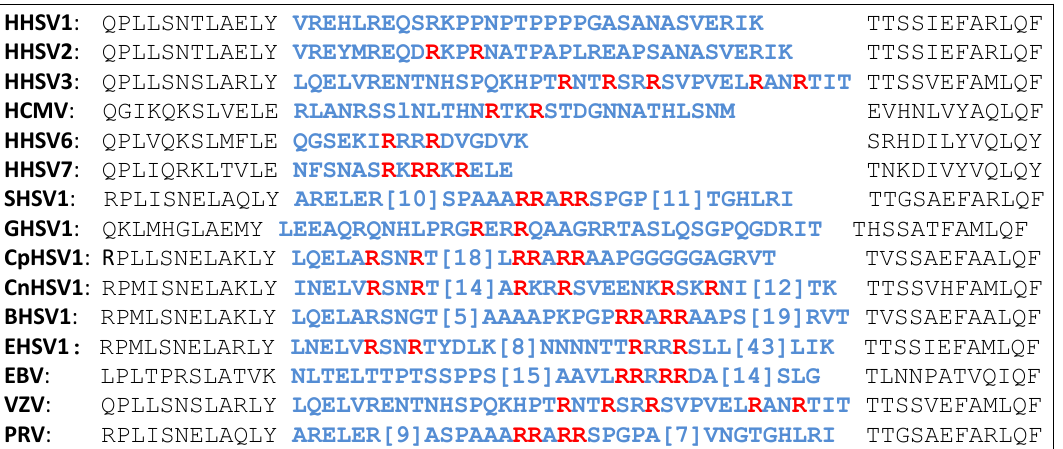
Table 3. PC cleavage site motifs in the glycoprotein B of herpes viruses. A highly variable loop in the viral glycoprotein B (residues in blue) contains PC cleavage site motifs (P4Arg and P1Arg residues are red). HHSV, human herpes simplex virus; SHSV, suid herpes simplex virus; GHSV, gallid herpes simplex virus; CpHSV, caprine herpes simplex virus; CaHSV, canid herpes simples virus; BHSV, bovine herpes simplex virus; EHSV, equide herpes simplex virus; EBV, Epstein-Barr virus; VZV, varicella-zoster virus; HCMV, human cytomegalovirus; PRV, pseudorabies virus.